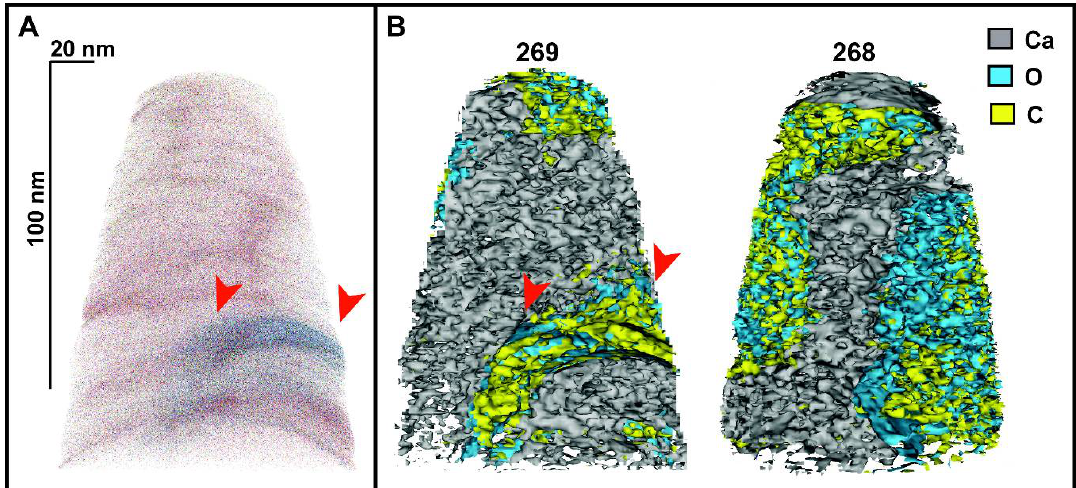
Figure 4. Example of 3D atomic ( A ) and elemental isosurface ( B ) tip reconstructions for calcite (tips 269 and 268), showing regions of higher concentrations of elements (for calcite, we identify the mineral phase with Ca >41% and the IOM with O + (>43%) and C + (>15%)). Note that all five tips that provided the best data (Tables 1 and 2) show similar characteristics to those illustrated here.